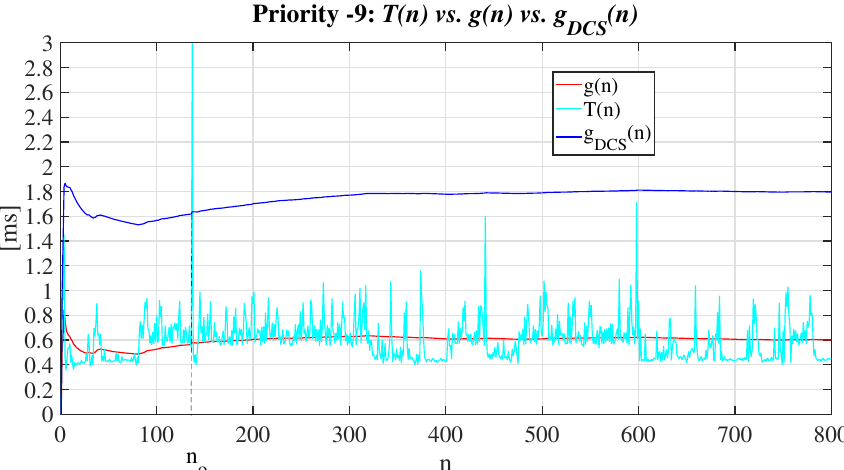
Figure 18. Temporary computational complexity analysis of the real-time quadrotor simulation algorithm using priority − 9.